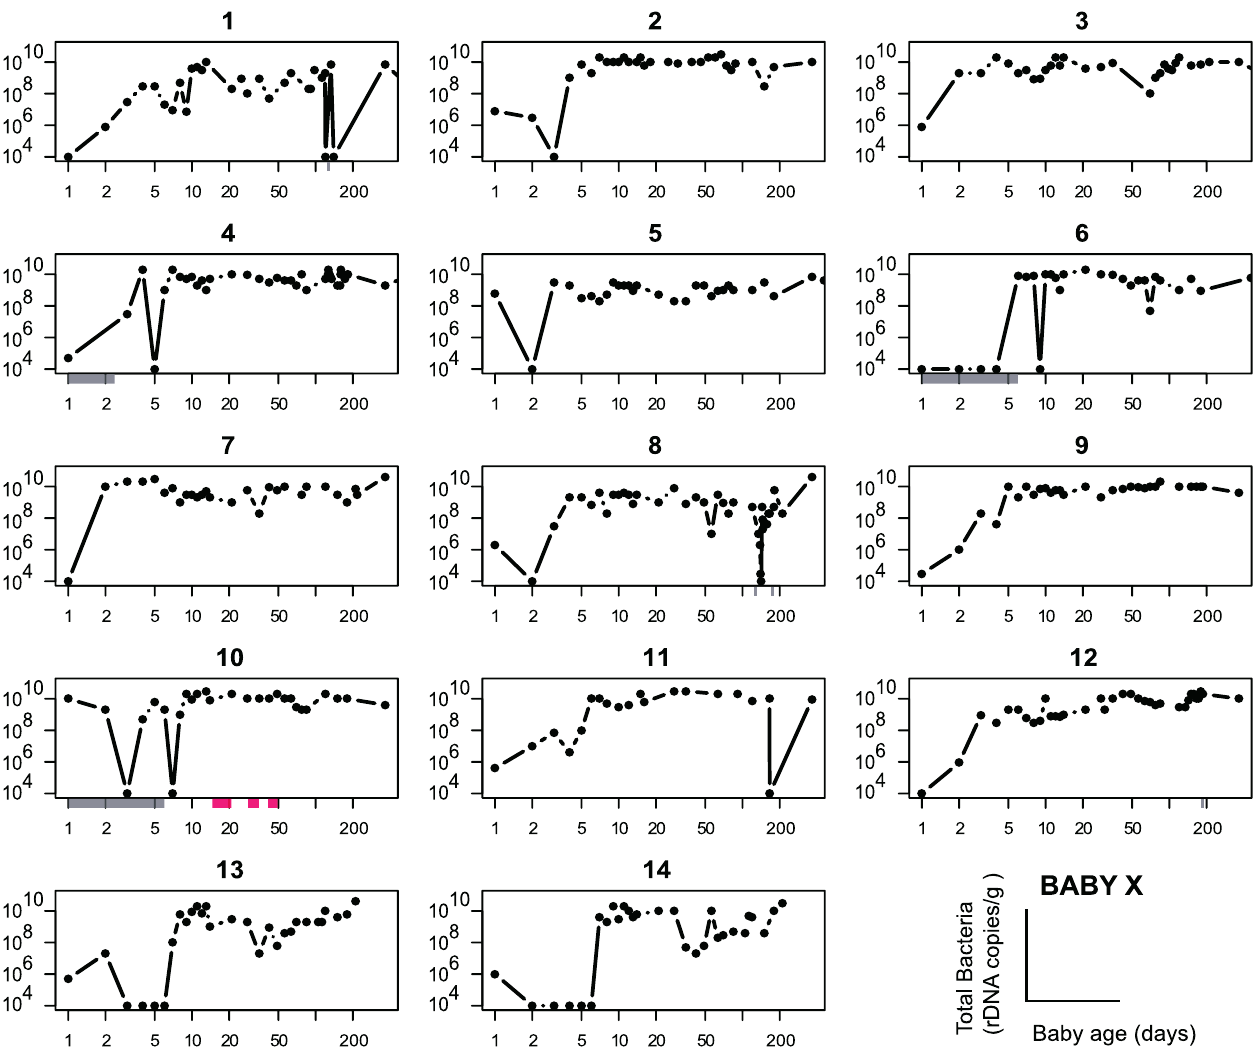
Figure 2. Variation in the Overall Density of Fecal Bacteria during the First Year of Life. For each baby sample, bacterial abundance was estimated by TaqMan real-time PCR with universal bacterial primers. Estimated rRNA gene copies per gram of feces ( y -axis) are plotted as a function of days of life ( x -axis). Both axes are on a logarithmic scale. Abundance measurements are truncated on the lower end at the value corresponding to the 95th percentile of the extraction (negative) controls (copy number corrected by median stool mass). Episodes of antibacterial or antifungal (nystatin) treatment are indicated on the temporal axis by gray or pink bars, respectively (see Table 1 for additional information).